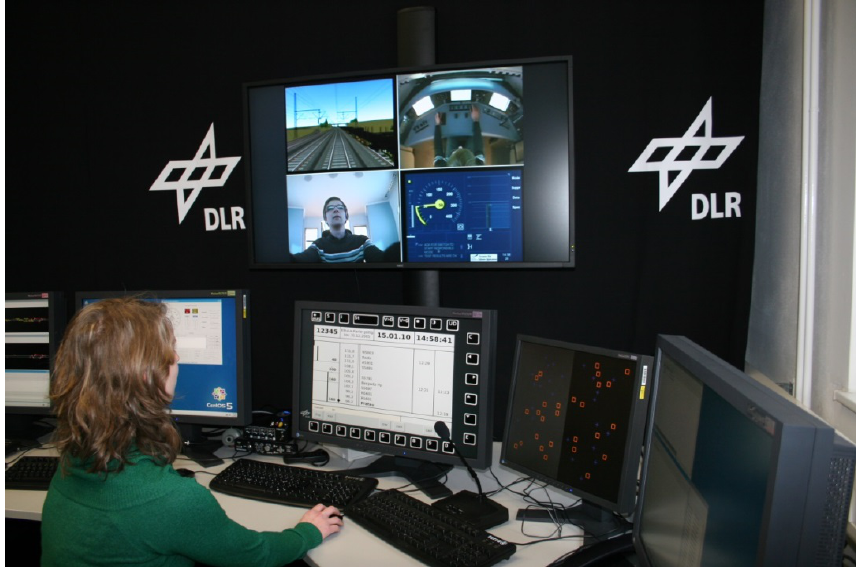
Figure 4: Investigator’s workplace associated to the